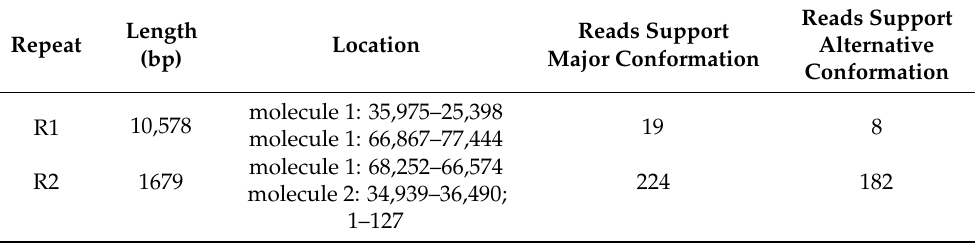
Table 1. Recombination frequency of the Q. acutissima mitogenome related to two long